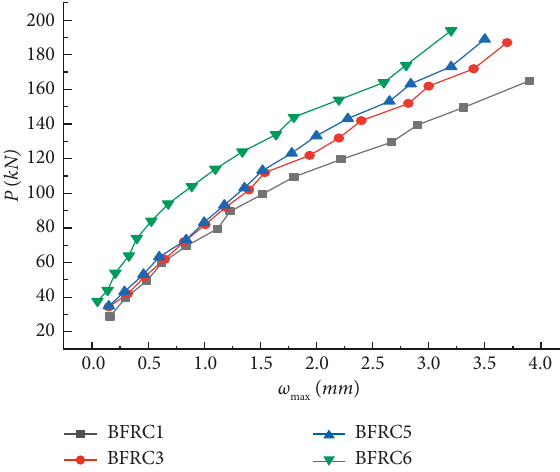
Figure 8: Load-maximum width curves of steel fiber concrete with different thicknesses.